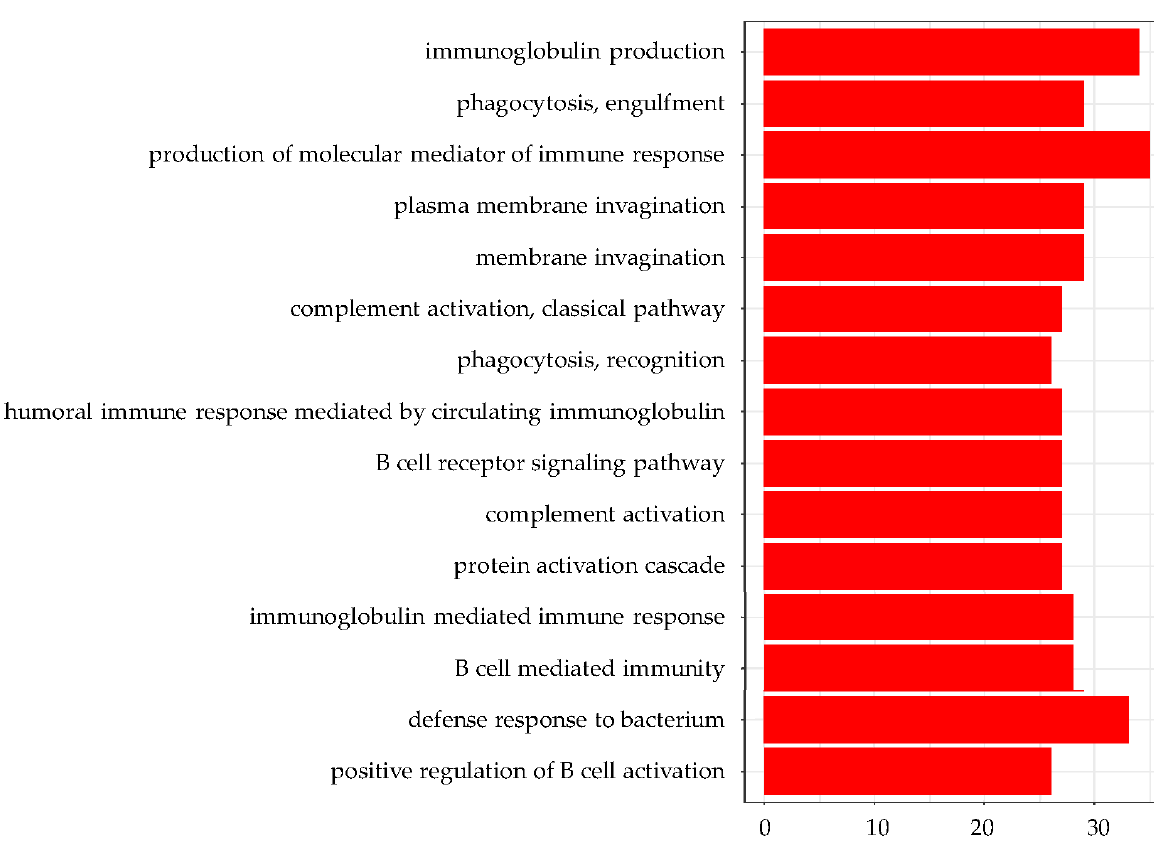
Figure 4. The top 15 GO terms from the DGAs for upregulated genes in the ileum.